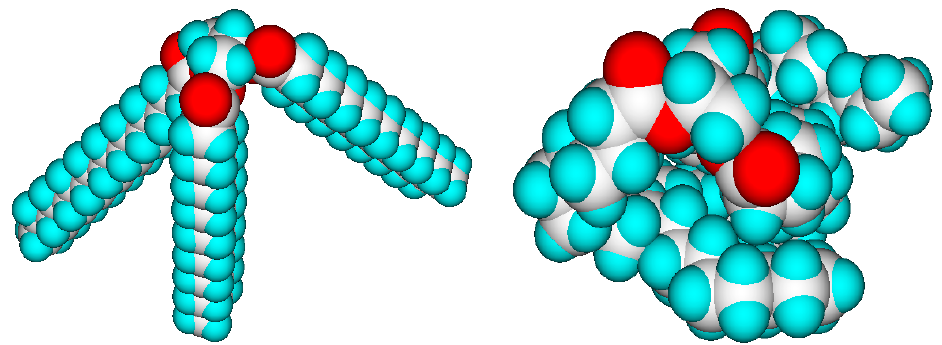
Figure 1. Energy-minimized forms of tristearin (graphics by ChemBrain IXL). ( Left ) stearyl chains stretched, Vm = 997.6 A 3 ; ( right ) stearyl chains randomly folded, Vm = 992.9 A 3 .